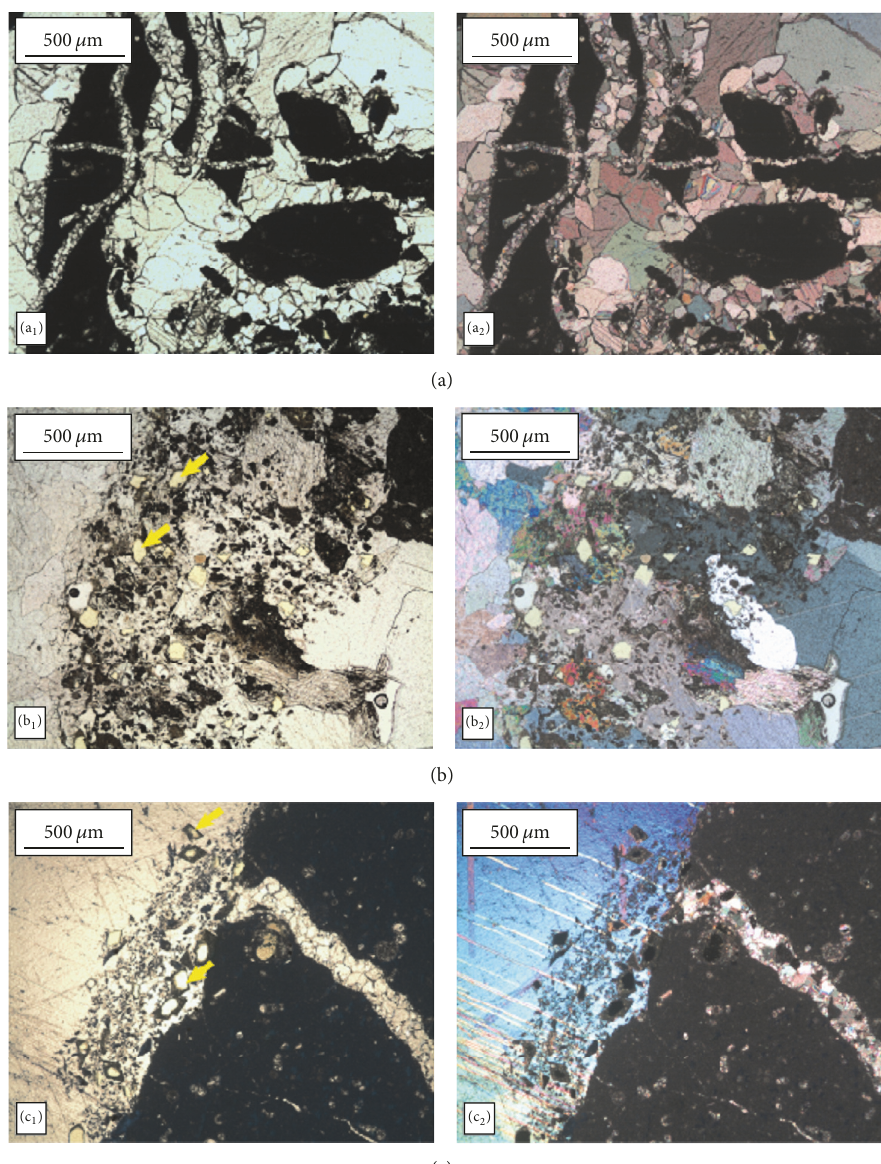
Figure 3: Microscopic observations under plane-polarized transmitted light (1) and crossed polars (2) . (a) Calcite-cemented breccia (Group II) with chalk fragments showing a typical jigsaw puzzle. Group I veins within chalk fragments. (b) and (c) Fringe of impurities along a chalk fragment within the calcite-cemented breccia. Note the rhombohedral crystal ghosts (yellow